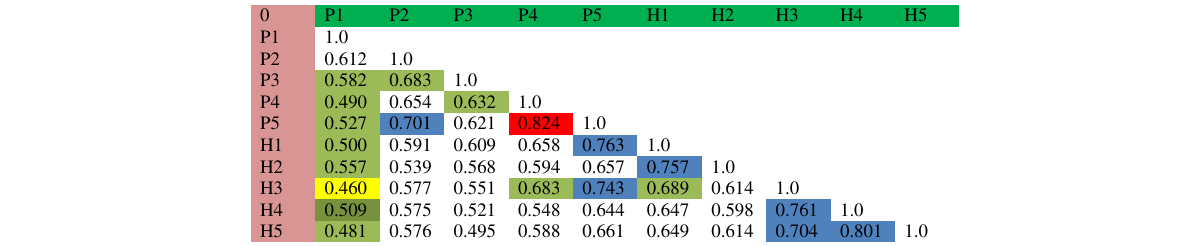
Table 13 Genetic similarity percentages of 10 sorghum entries using 8 ISSR primers